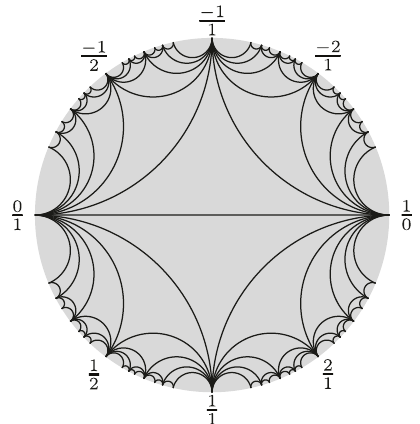
Figure 10 . All vertices of the Farey tessellation on the boundary circle can be labelled as follows: start with the three points 0 = 1, 1 = 0, and 1 = 1; then given any pair of labelled vertices ( p=q; r=s ) of a triangle, label the third vertex in that triangle with the fraction ( p + r ) = ( q + s